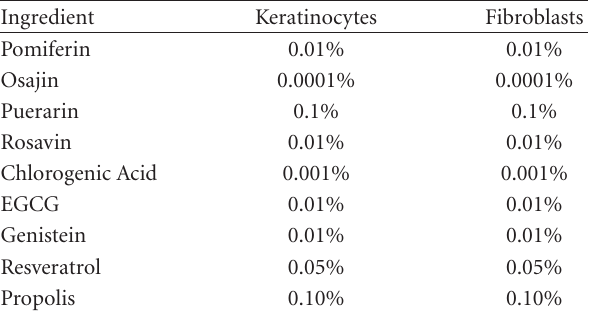
Table 1: Concentrations of various ingredients tested on Ker- atinocytes and